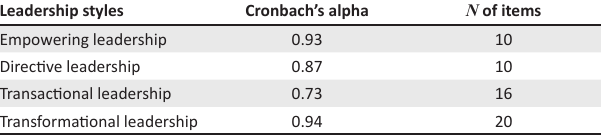
TABLE 4: Reliability data ( n =